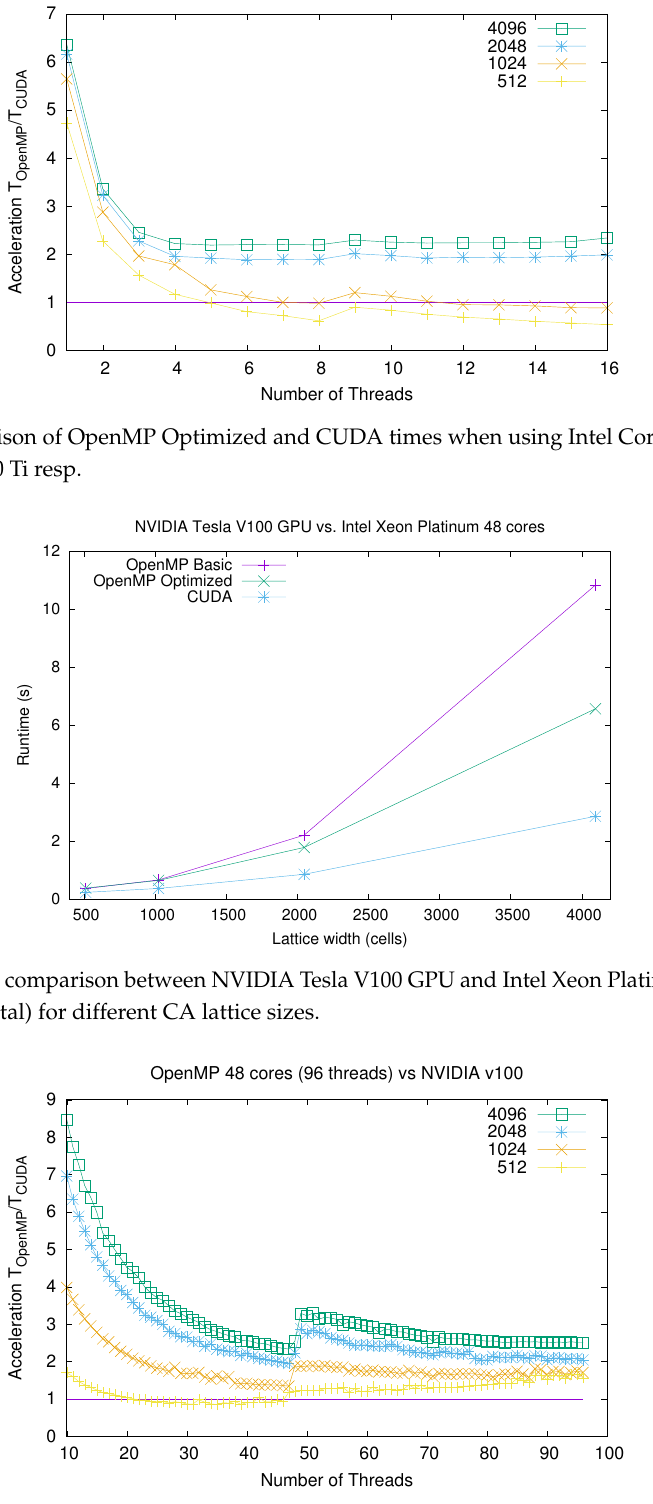
Figure 7. Comparison of OpenMP Optimized and CUDA times: Detail from 10 threads up when using Intel Xeon Platinum and NVIDIA Tesla V100 GPU,